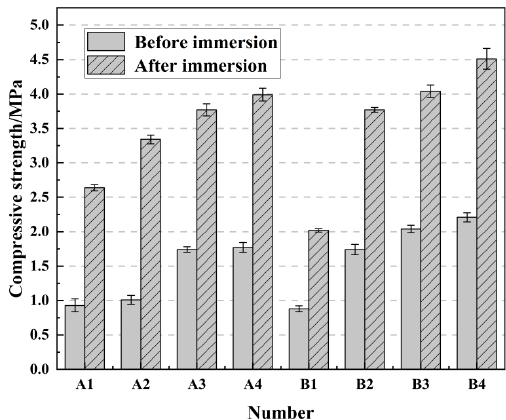
Figure 6. Change of compressive strength in 7 days curing age immersion curing.